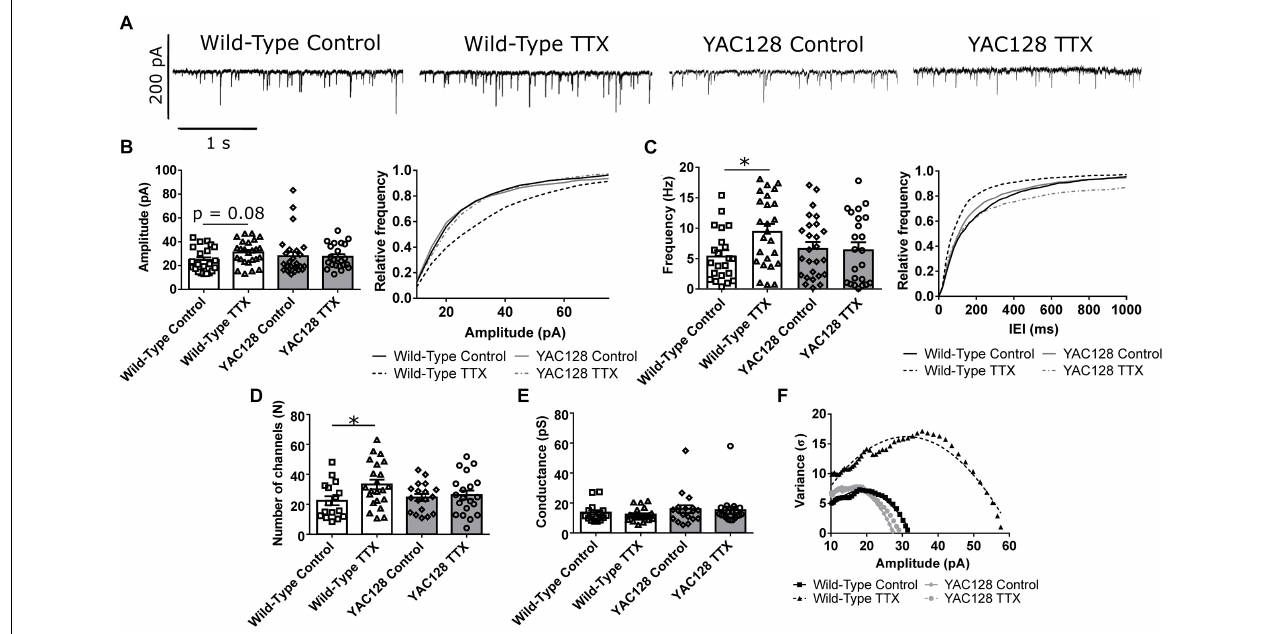
FIGURE 1 | Impaired homeostatic plasticity in YAC128 cortical pyramidal neurons (CPNs). (A) Representative traces of miniature excitatory postsynaptic currents (mEPSC) recordings from wild-type (WT) and YAC128 CPNs treated with tetrodotoxin (TTX) or vehicle control. (B) mEPSC average amplitude (left panel) and amplitude cumulative probability (right panel). There is a trend toward increased mEPSC amplitude in WT CPNs treated with TTX ( p = 0.08, Bonferroni post hoc t -test), but not in YAC128 CPNs treated with TTX ( p > 0.99, Bonferroni post hoc t -test). (C) mEPSC average frequency (left panel) and inter-event interval (IEI) cumulative probability (right panel). There is increased mEPSC frequency in WT CPNs treated with TTX ( ∗ p < 0.05, Bonferroni post hoc t -test), but not in YAC128 CPNs treated with TTX ( p > 0.99, Bonferroni post hoc t -test; TTX p = 0.07, genotype/TTX interaction p < 0.05, two-way ANOVA). For (B) and (C) , cell numbers are WT control n = 22, WT TTX n = 25, YAC128 control n = 26, YAC128 TTX n = 23; culture batch N = 6. (D) Number of AMPARs per synapse. WT CPNs treated with TTX had more AMPARs per synapse ( ∗ p < 0.05, Bonferroni post hoc t -test), while YAC128 CPNs treated with TTX did not ( p > 0.99; TTX p < 0.05,